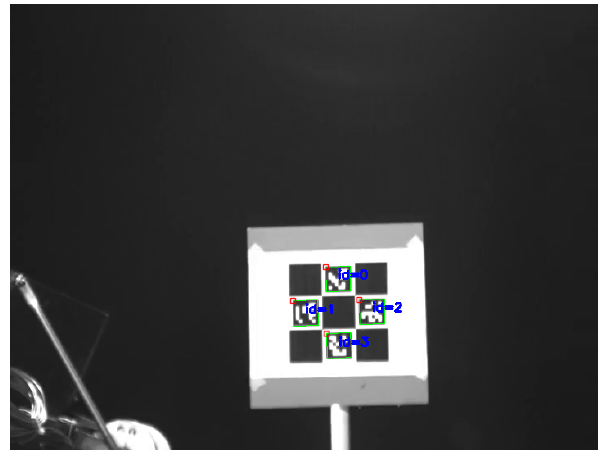
Figure 12. Charuco calibration chessboard.